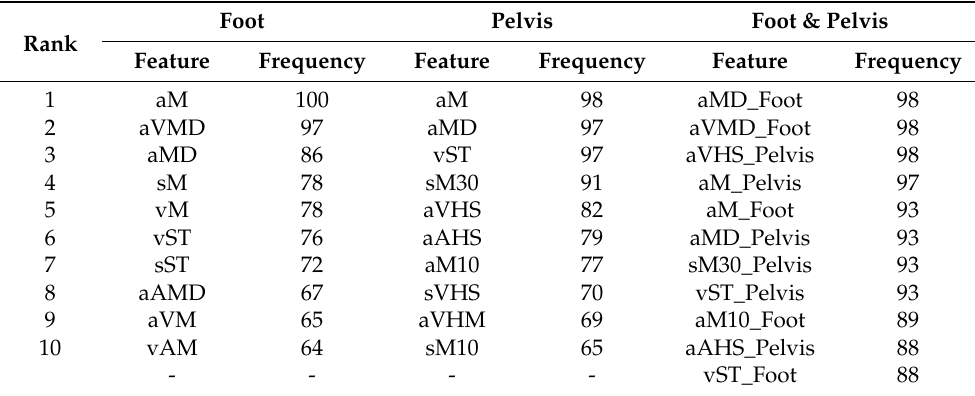
Table 5. Top 10 most selected features.